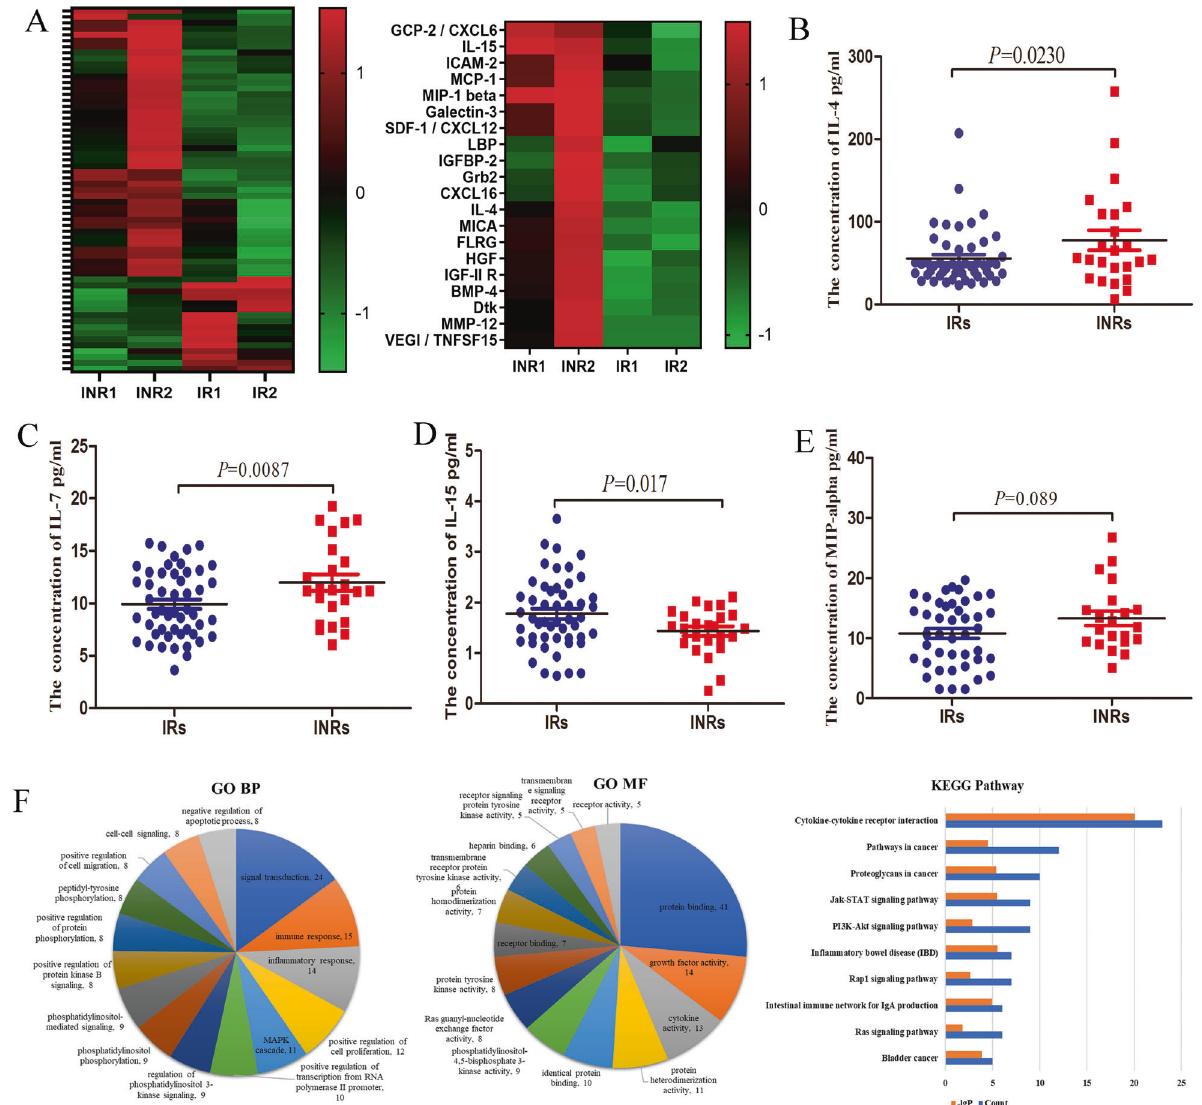
Fig. 8 Cytokine pro fi le between INR and IR. A Heatmap of signi fi cantly expressed cytokine between INRs and IRs using cytokine antibody microarray. B , C , D , and E Concentrations (pg/ml) of IL-4, IL-7, IL-15, and MCP-1 in the plasma samples obtained from INR and IR patients. F GO and KEGG analyses were conducted using DAVID for upregulated cytokine in plasma from INRs compared with